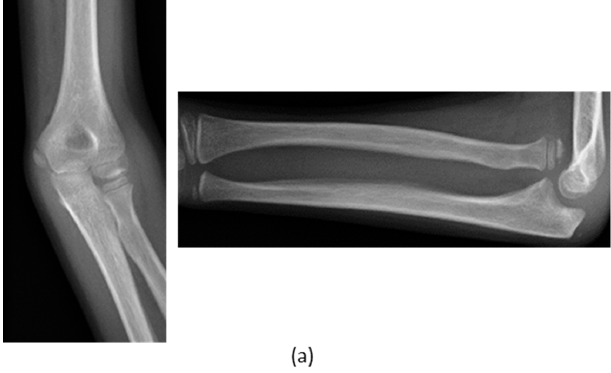
Figure 4. A nine-year-old girl with a missed Monteggia lesion. ( a ) Antero-posterior and lateral X-Ray; ( b ) CT scan with 3D reconstruction: the affected elbow showed the typical dislocation of the radial head associated with bowing of the ulna. A cap calcification is visible over the radial head. Figure 5. Simulation process: ( a ) the reconstructed 3D model is prepared for simulation through the definition of geometrical references; ( b ) the cutting plane DTM1 meets the axis A_1 defining the